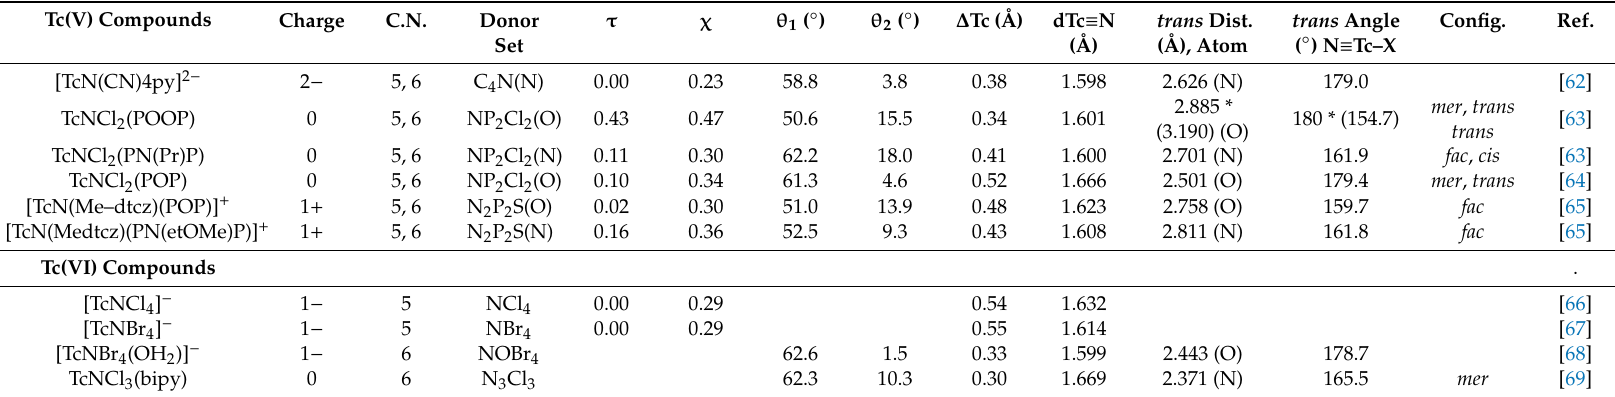
Config. = (1) Tc(V) complexes: (a) in complexes having tridentate and bidentate ligands, it informs about whether or not the tridentate ligand attempts to take a triangular face of the octahedron; (b) in compounds having a tridentate and two monodentate ligands, it informs about the arrangement of the tridentate ligand and on the reciprocal position of identical monodentate ligands. (2) Complex TcNCl 3 (bipy) [69]: it informs on the reciprocal orientation of the chloride ligands. * Complex TcNCl 2 (POOP) [63] is peculiar in having two, rather than one, donor atoms (O) attempting to take the sixth coordination position of the octahedron. Starred figures refer to the geometric centroid of these oxygen donors; real values of trans distance and angles (identical by symmetry for the two oxygen atoms) in